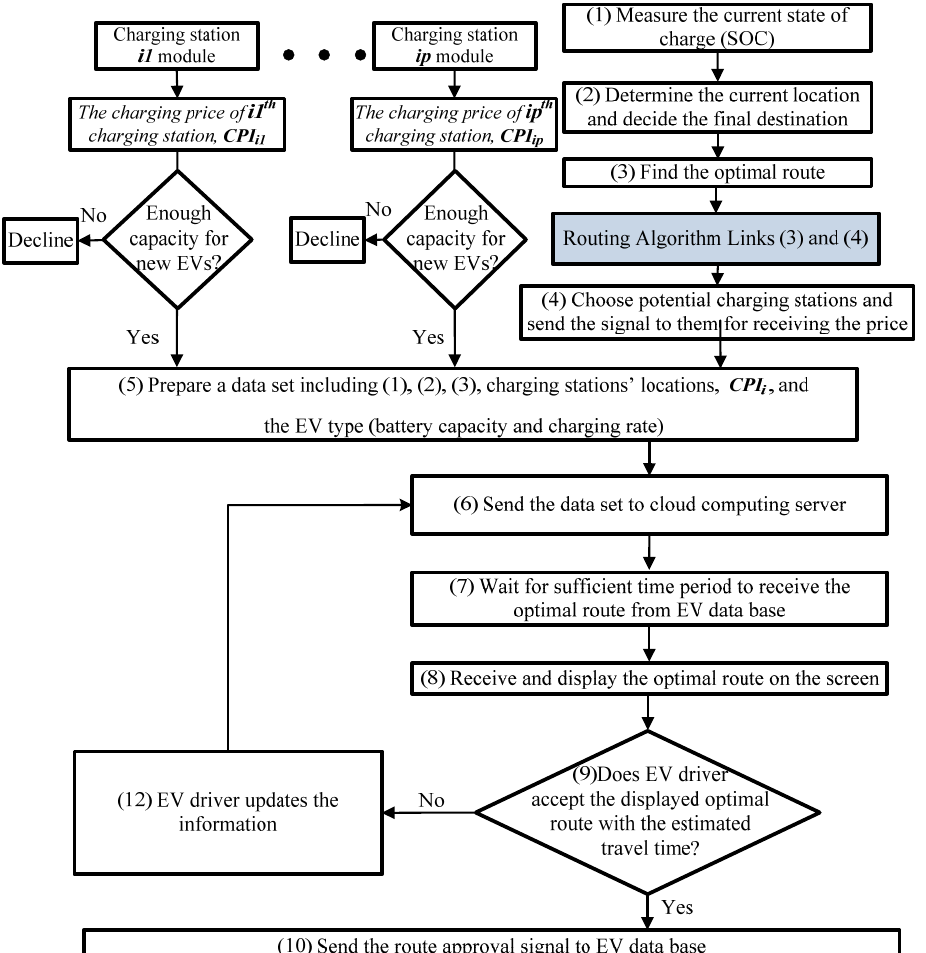
Figure 4. Electric vehicle module representation. Energies 2018 , 11 , 196 FOR PEER REVIEW